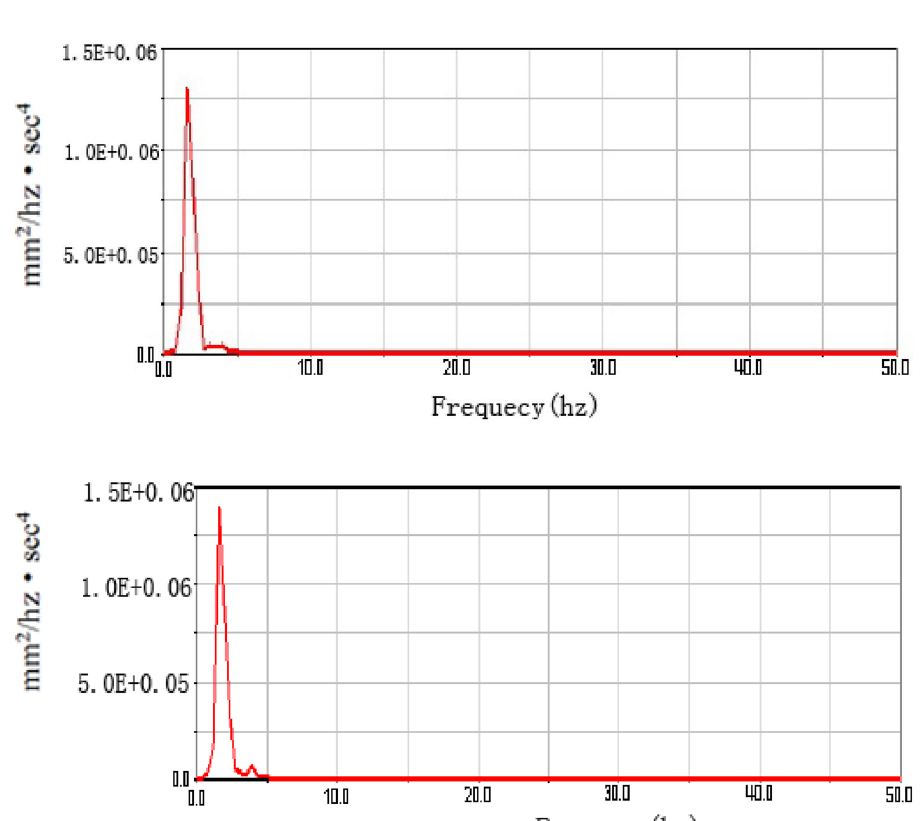
Fig. 8 Test 3. Acceleration Response Curve